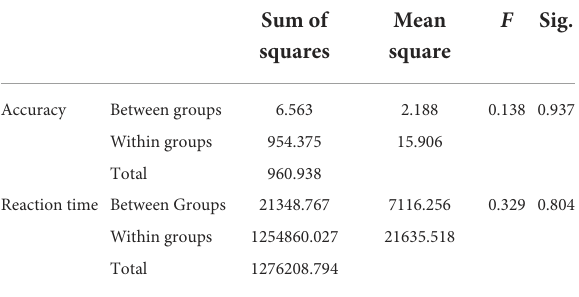
F Sig. Sum of Mean squares square